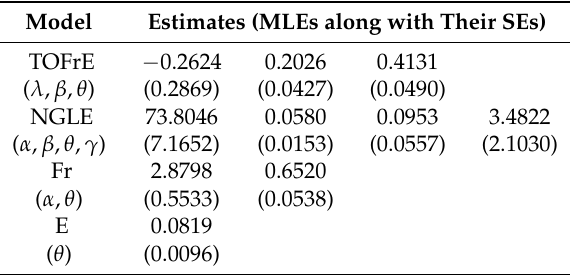
Table 9. MLEs and SEs of the models for Data set